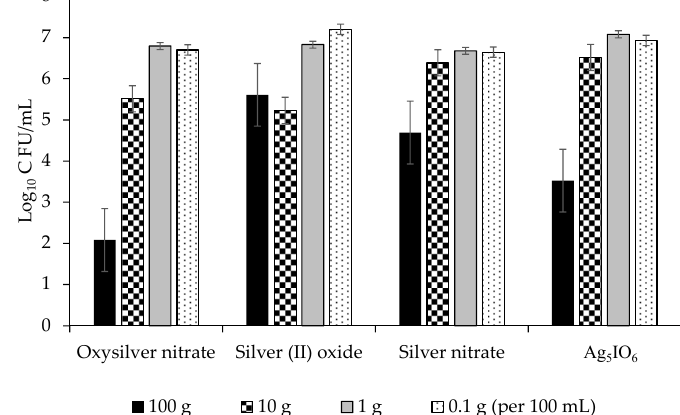
Figure 6 . Effects of four silver-based seed coatings on the lg growth (CFU/mL) of Pseudomonas syringae pv. phaseolicola .